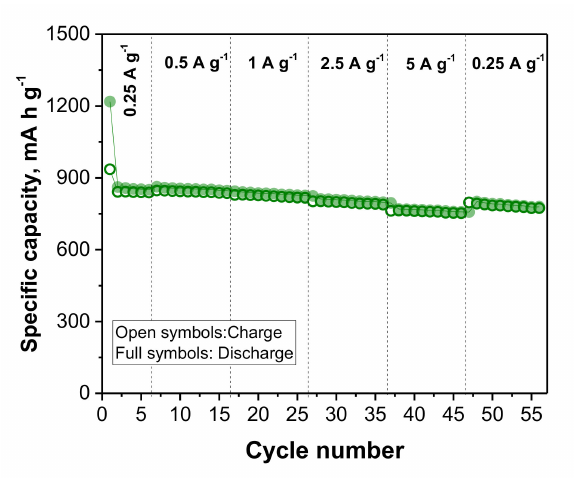
Figure 6. Rate performance of e-BMW. Voltage window: 0.05–0.9 V. 1 st activation cycle: 0.005–0.9 V at 100 mA / g.